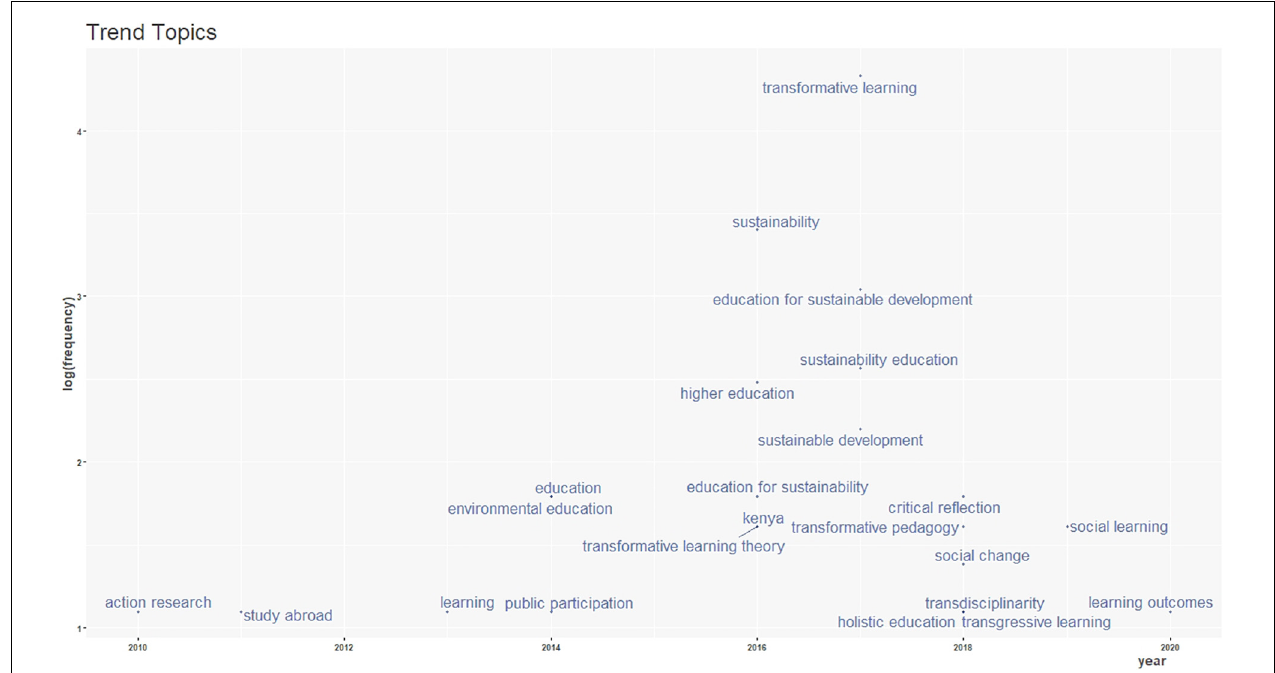
FIGURE 9 | Evolution of trend topics of authors’ keywords (minimum frequency of